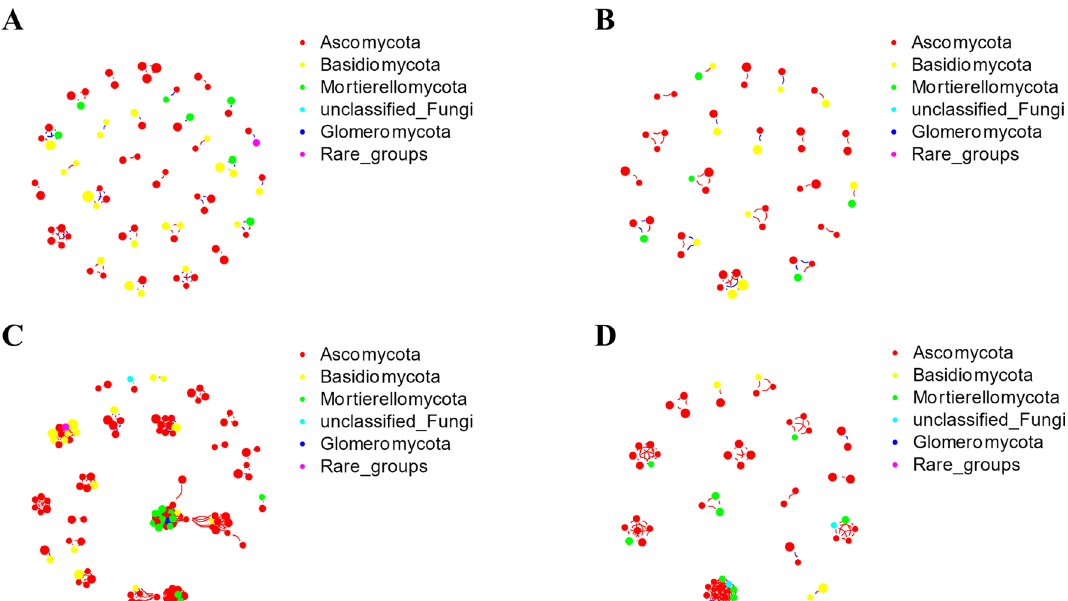
Figure 7. Fungal coexpression network analysis of healthy wheat and inoculated wheat of resistant and susceptible wheat varieties. ( A ) Coexpression network of inoculated resistant wheat. ( B ) Coexpression network of healthy resistant wheat. ( C ) Coexpression network of inoculated susceptible wheat. ( D ) Coexpression network of healthy susceptible wheat. Positive interactions are depicted as red edges, and the negative interactions are depicted as blue edges. Descriptive and topological network properties were performed with the R package igraph 44 . The co-occurrence networks were using the “Fruchterman-Reingold” layout with 10 4 permutations in igraph 45 .